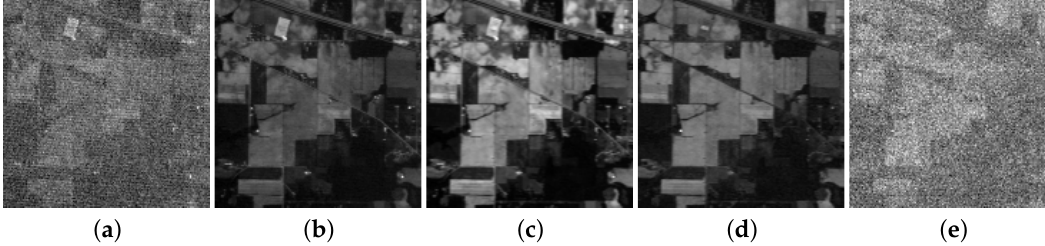
Figure 1. Five representative bands of Indian Pines image ( a ) band 1, ( b ) band 10, ( c ) band 30, ( d ) band 200 and ( e ) band 220.